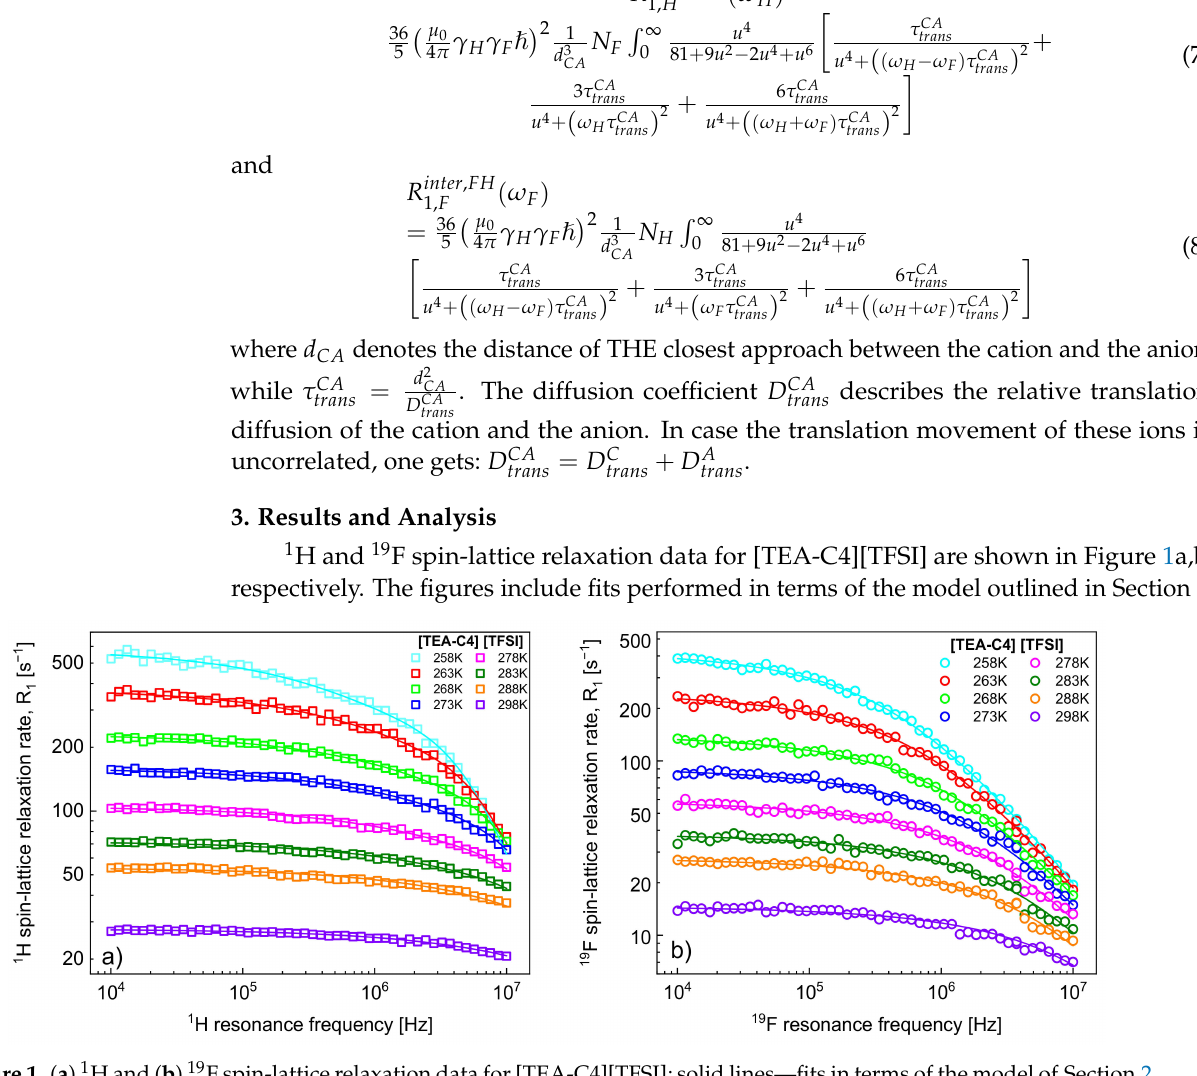
Figure 1. ( a ) 1 H and ( b ) 19 F spin-lattice relaxation data for [TEA-C4][TFSI]; solid lines—fits in terms of the model of Section